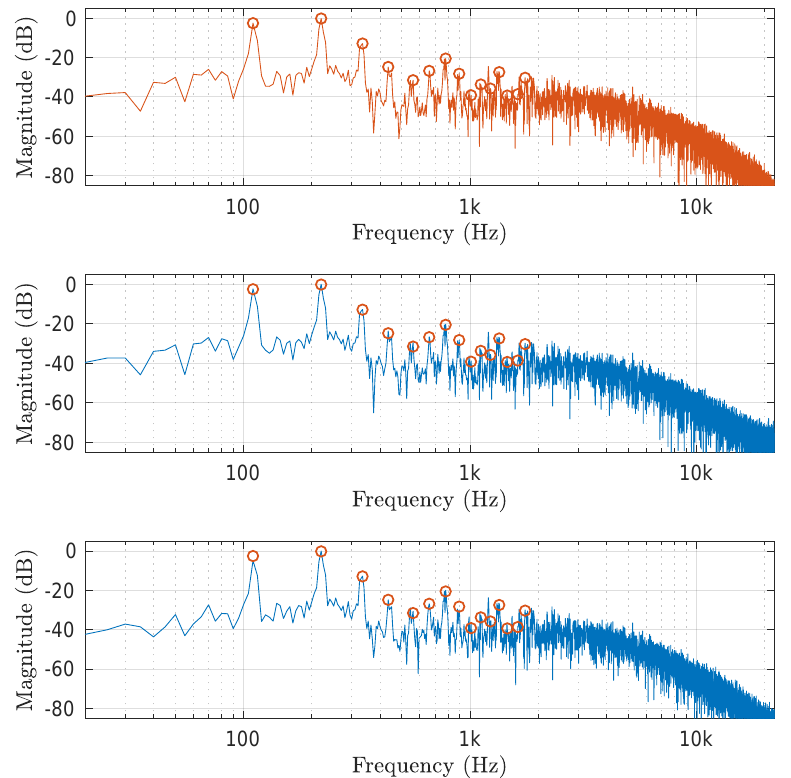
Figure 16. Spectrum of a guitar sound processed ( top ) through the HT5M guitar amplifier, ( middle ) through the WaveNet3 model, and ( bottom ) through the RNN-96 model. The circles indicate the level of the first 15 harmonics in the target spectrum.